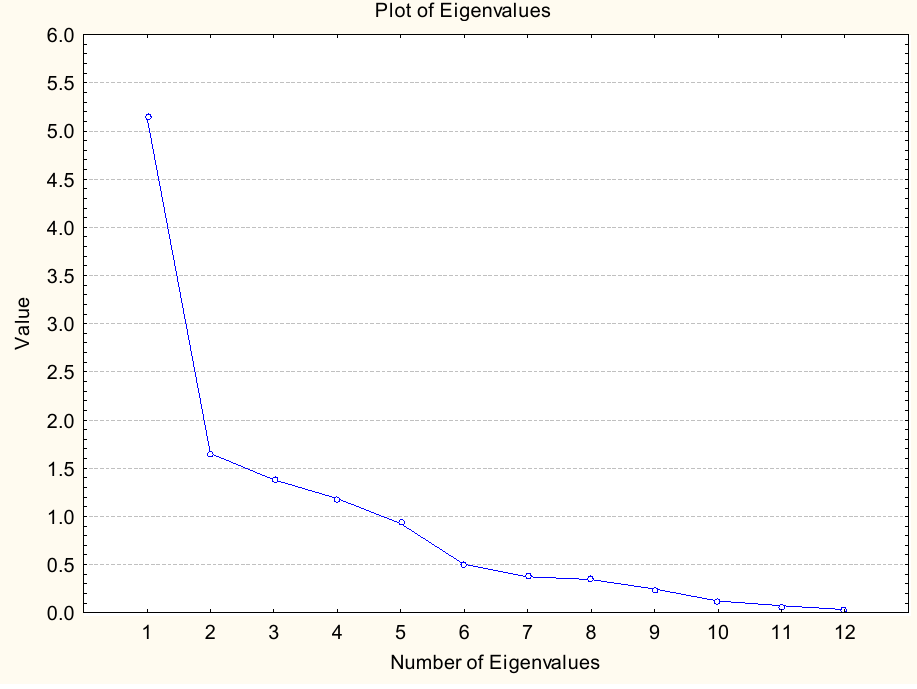
Figure 5: Plot of eigenvalues.